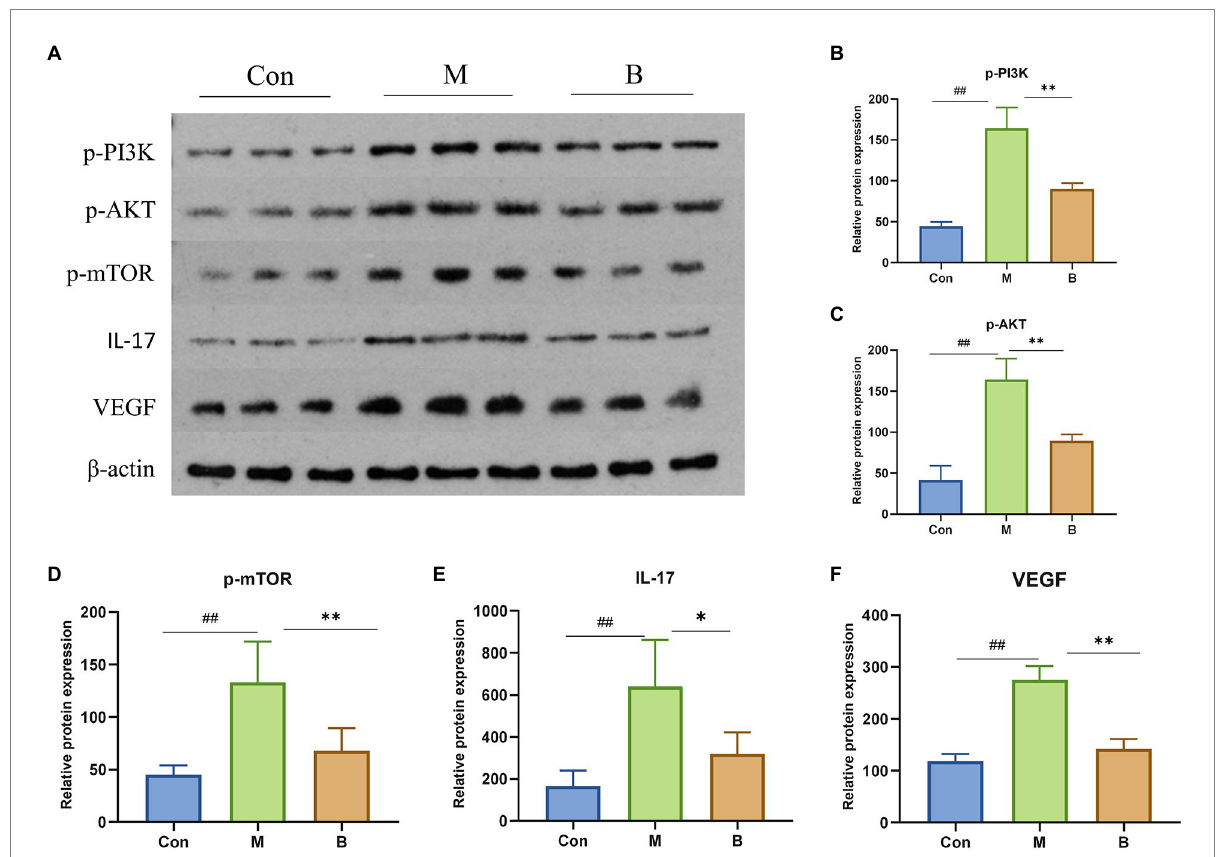
FIGURE 7 Protein expressions of PI3K, AKT, mTOR, IL-17 and VEGF in liver (A) PI3K, AKT, mTOR, IL-17, VEGF protein expression in liver tissue (B–F) n = 3, ## p < 0.01; compared with the Con group, # p < 0.05; ## p < 0.01; compared with the M group, * p < 0.05; ** p <